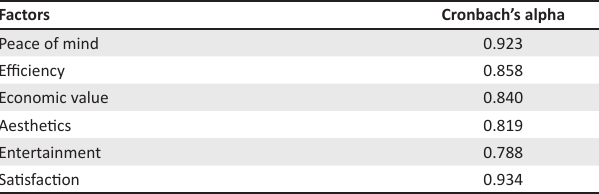
TABLE 2: Reliability test.